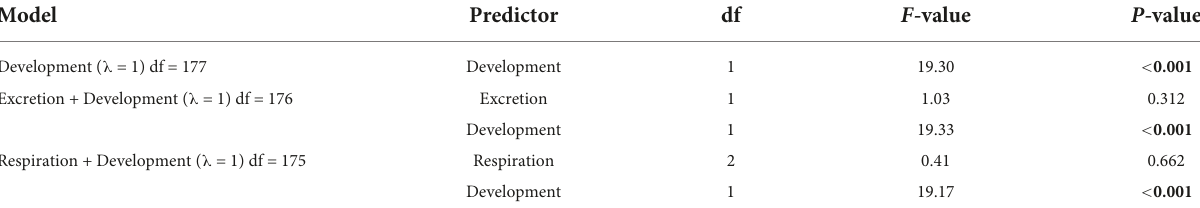
TABLE 3 ANOVA results for the phylogenetic generalized least-square (PGLS) models with (cid:49) AICc < 4 obtained for the complete Decapoda dataset. Model